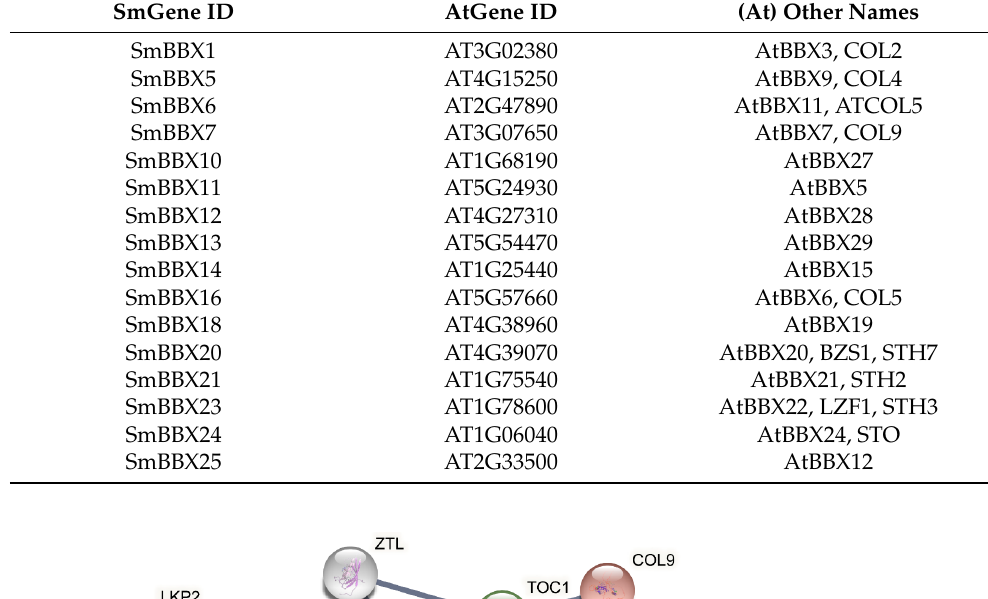
Table 4. Homologous Arabidopsis thaliana and Salvia miltiorrhiza genes of the BBX family.